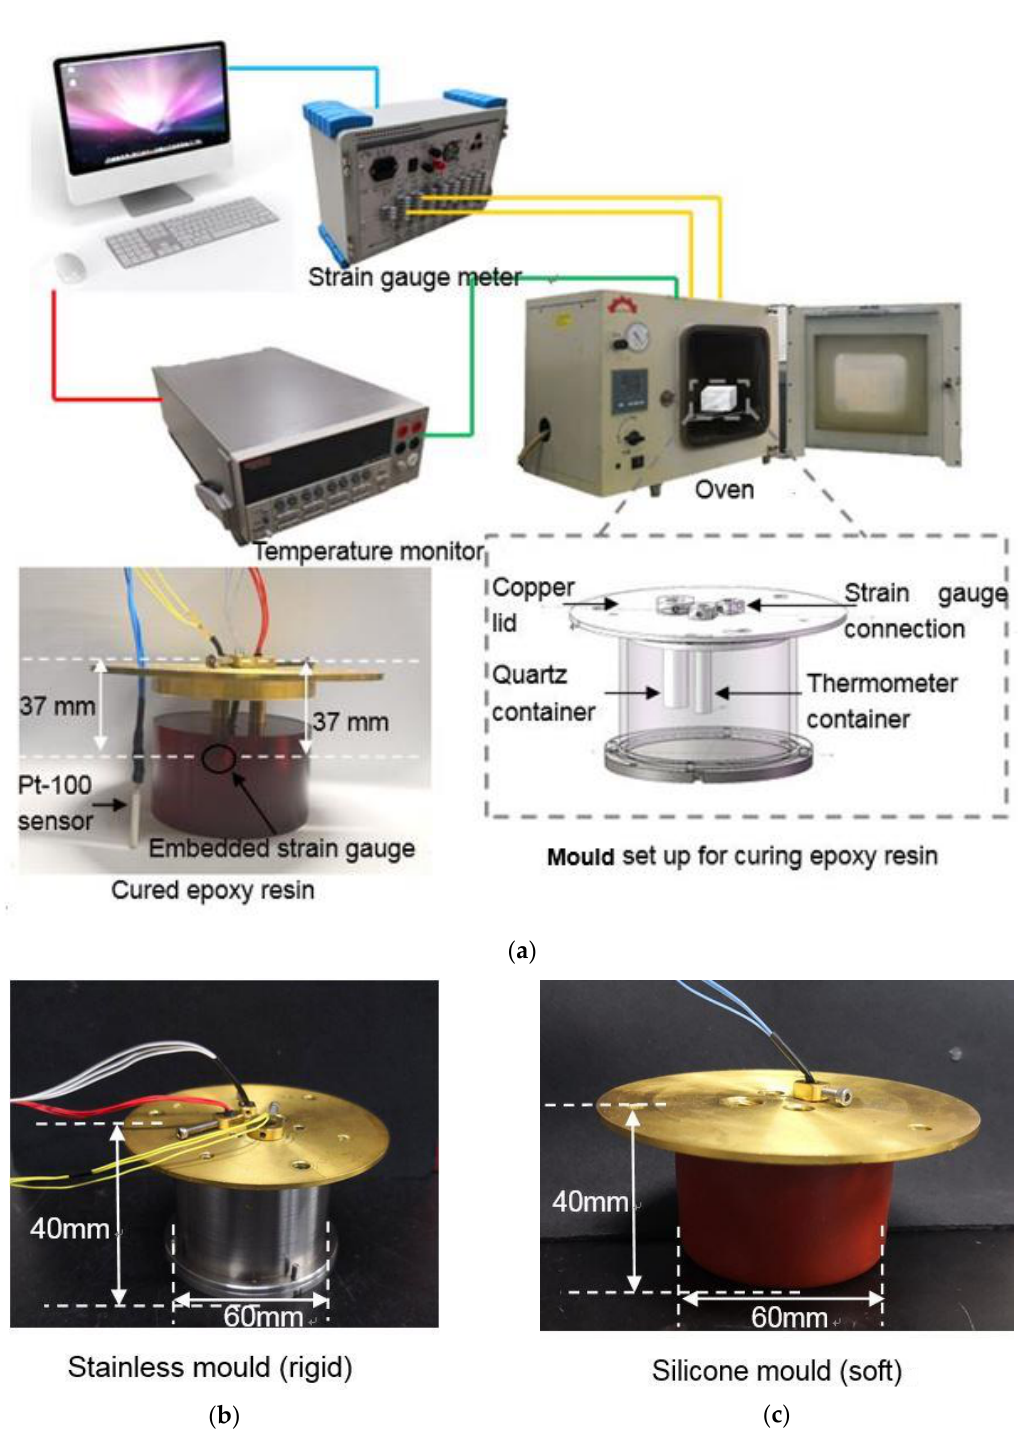
Figure 2. ( a ) schematic diagram of the test setup, ( b ) the stainless steel mould, and ( c ) the silicone mould.